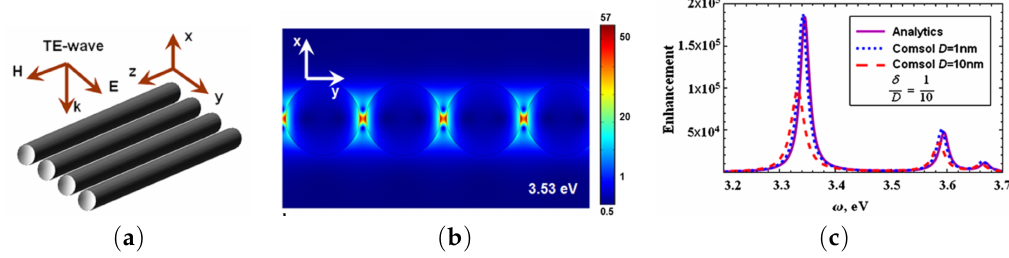
Figure 2. ( a ) scheme of the TE-wave propagation for an array of closely packed nanocylinders; ( b ) electric field mapping of surface plasmon resonances in an array of Ag cylinders with the following parameters: ω = 3.53 eV, cylinder radius a = 5nm, interparticle distance δ = 1nm; ( c ) comparison of analytical (purple line) and numerical (blue and red dashed lines) enhancements | E m / E 0 | 2 of the electromagnetic (EM) field in the middle of dimer. The ratio δ / D is equal to 0.1, the nanorod diameter for COMSOL simulations is D = 2 a = 10nm or 1nm, and E 0 is amplitude of incident light, reprinted by permission from Springer Nature: Springer Nature, Applied Physics A: Materials Science and Processing [11], Copyright